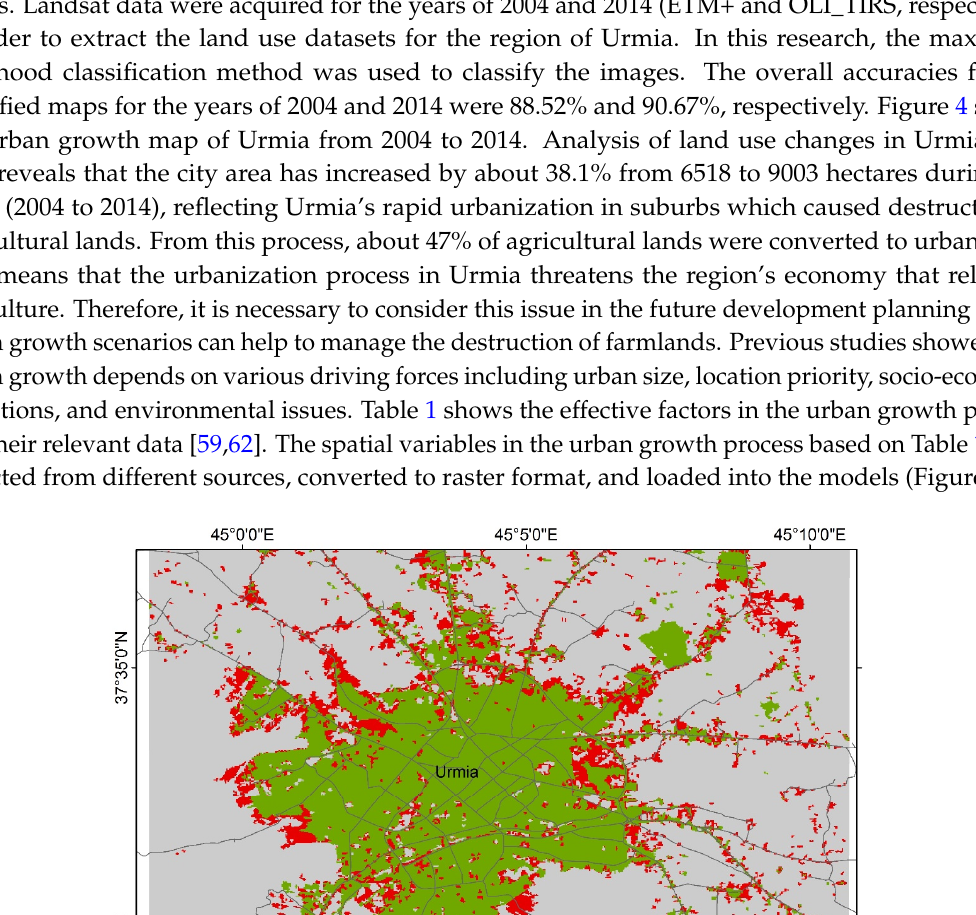
Figure 3. Iran, West Azarbayjan Province and the city of Urmia.